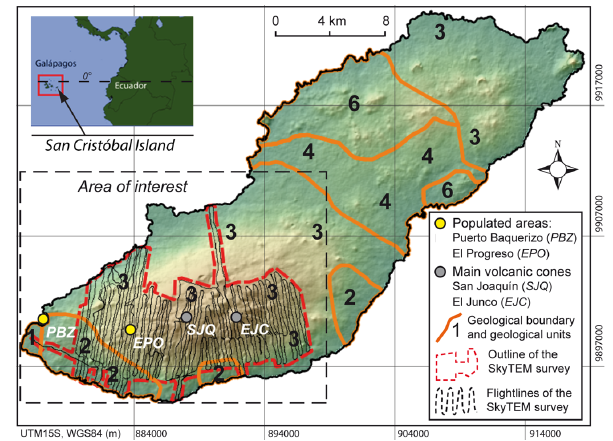
Fig. 1. Geographical settings of San Crist´obal Island. Shaded relief map from the SRTM digital elevation model (Rabus et al., 2003). Geological boundaries from Geist et al. (1986), with ages from the older (1, 2.3Ma) to younger (6, historical) formations. Age 2 are reversely polarized flows ( > 0.78Ma) and age 3 to 6 are normally polarized ( <